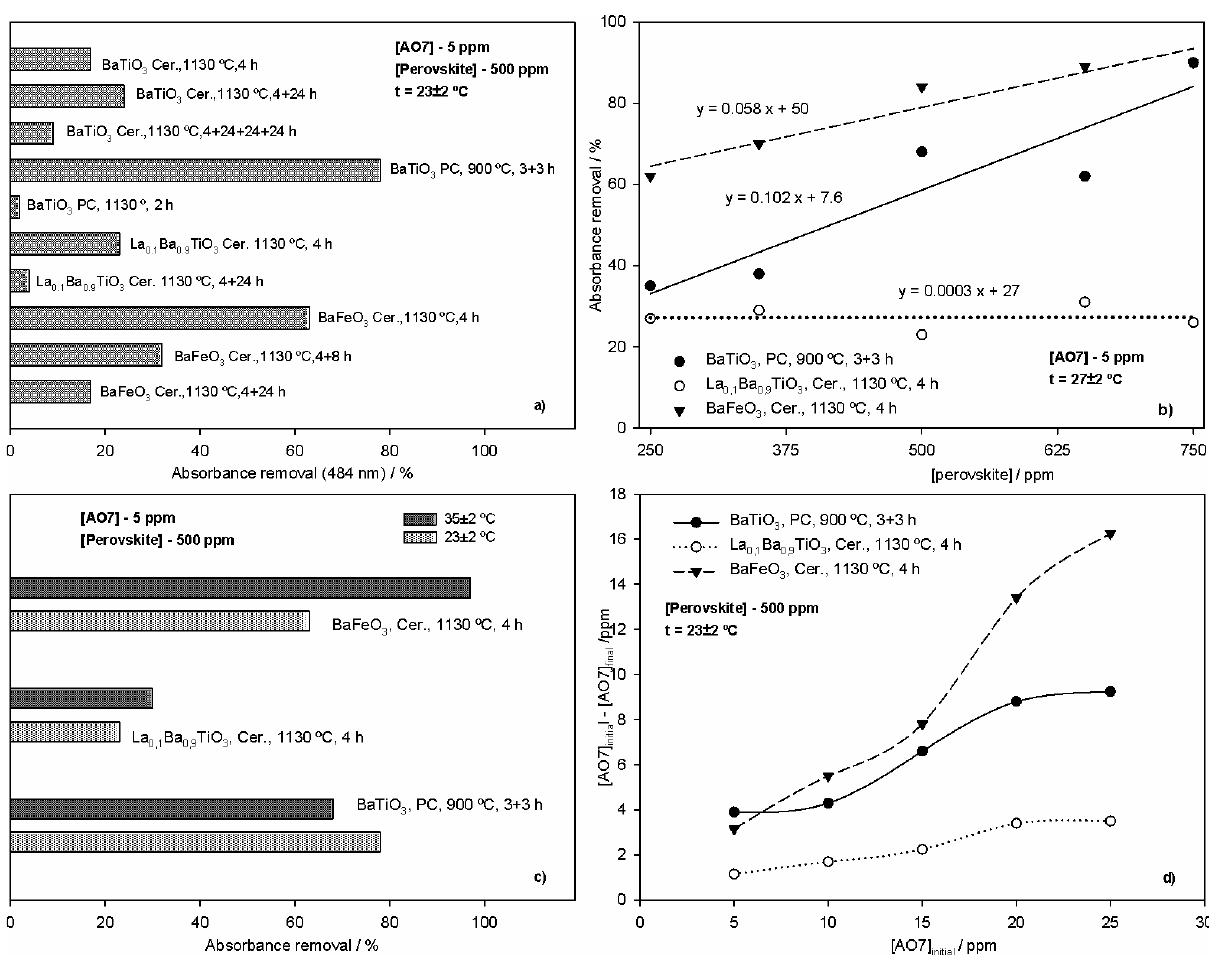
Figure 3: Influence on the absorbance removal of (a) the type of perovskite, (b) perovskite concentration and (c) temperature for the assays performed with AO7 5 ppm solutions and (d) AO7 removal for different initial AO7 concentration, for the photocatalytic degradation assays. Cer – Ceramic method; PC – Complex polymerization